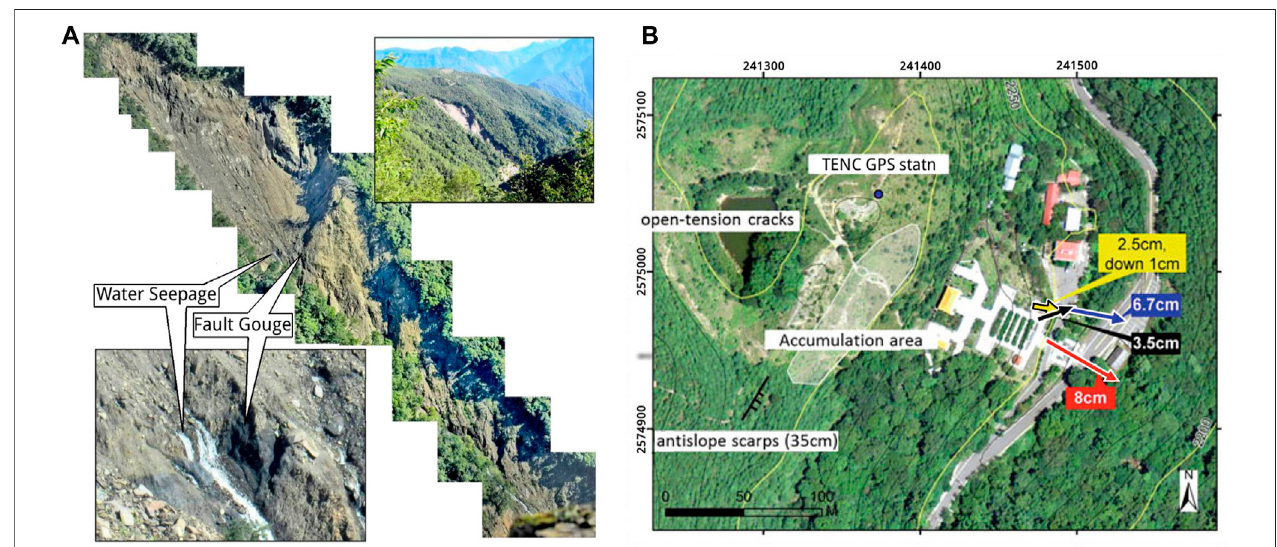
FIGURE 5 | (A) The slope pro fi le of a shallow landslide in the TienChih area after the Morakot typhoon, (the central scarp near the rainfall gauge marked in Panel 2A ). A typical cleavage structure (fault gouge zone) in the area and underground water seepage are shown. (B) Crack openings in the main building site of the roadway rest